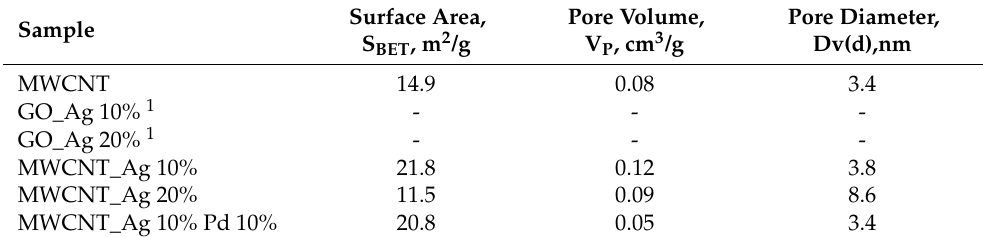
Table 1. The textural characteristics of the supports and catalysts.